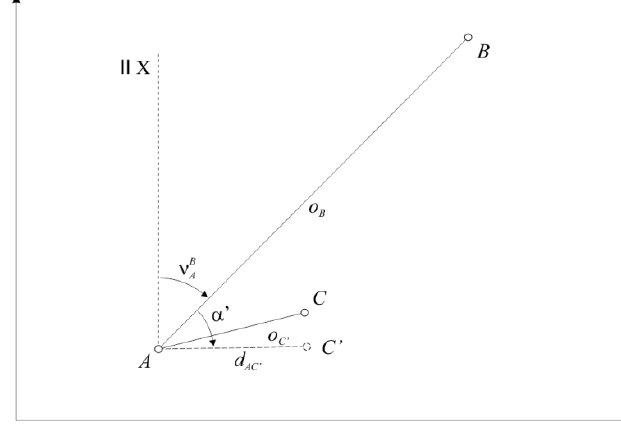
Figure 5. Displacement at control point 𝐶 : geometry.